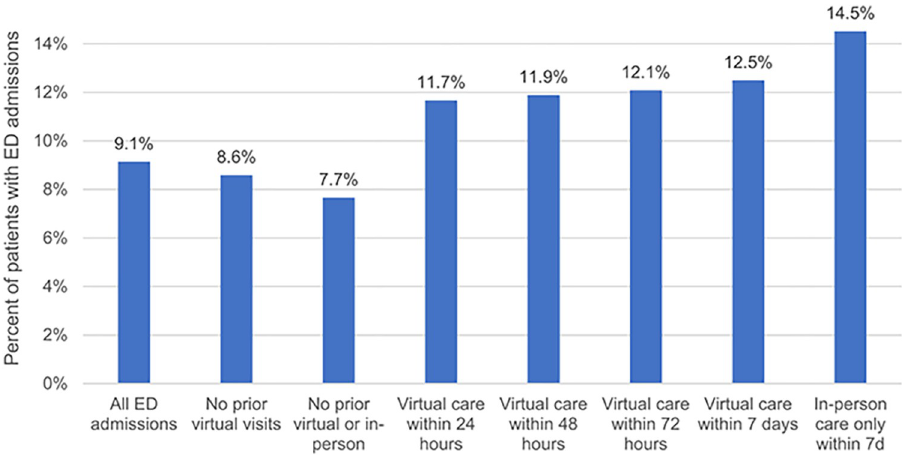
Fig 2. Percentage of patients with ED admissions that resulted in hospitalization across subgroups of patients with varying use of virtual care prior to admission.